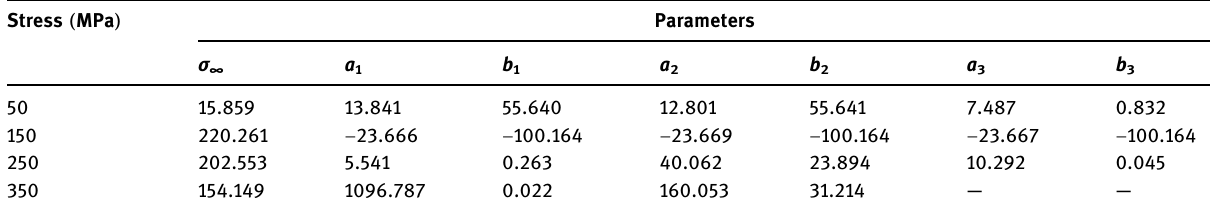
Table 2: Curve fi tting results of stress relaxation of 2219 aluminum alloy Stress ( MPa